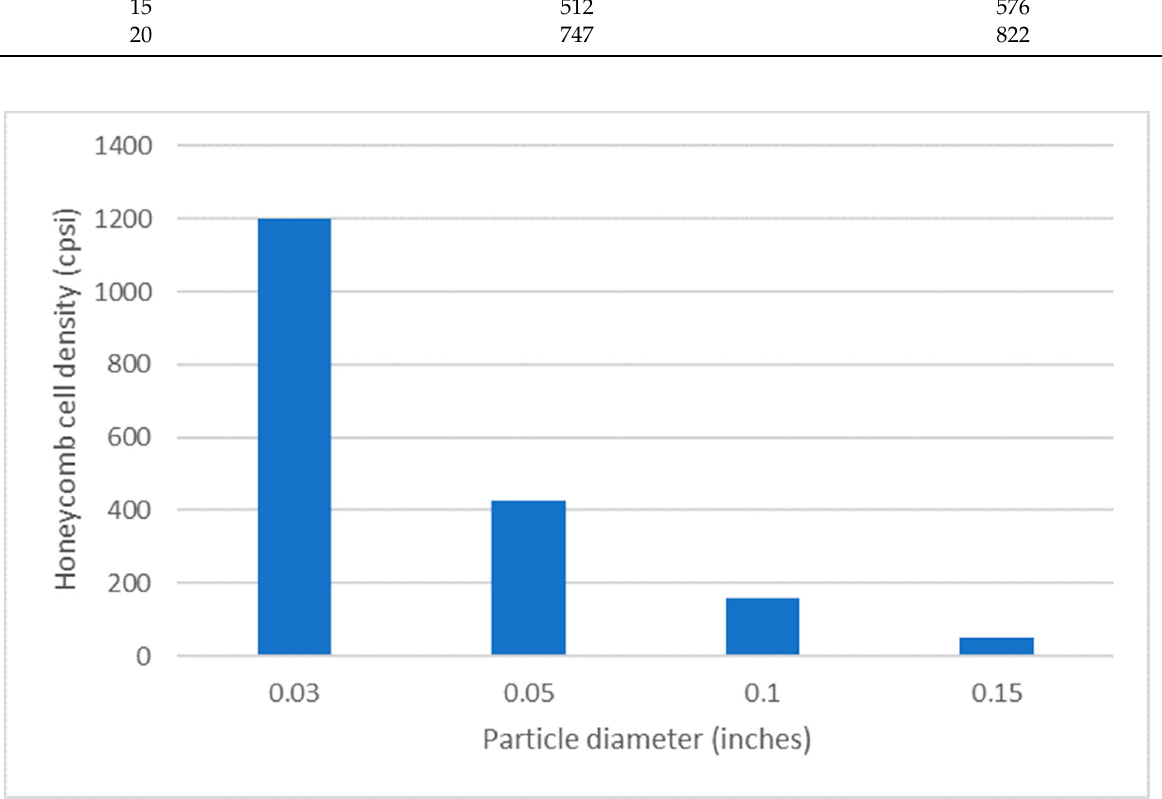
Figure 7. Comparison of a monolith with particulate as a catalyst support at equivalent surface areas. Adapted from [56].